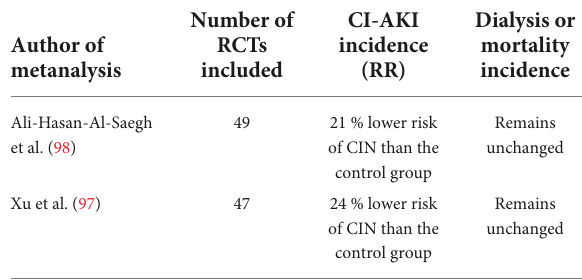
TABLE 8 Comparing meta-analysis of NAC treatment as a prevention method for contrast associated acute kidney injury.